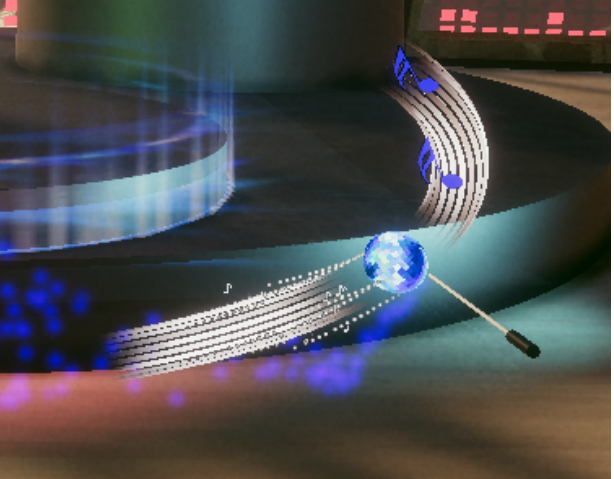
Figure 1. The disco ball that the player has to follow on a virtual path that resembles staff lines. The baton emits blue sparkles to highlight that the right hand has to be used. Notes are used as measurement points for accuracy.